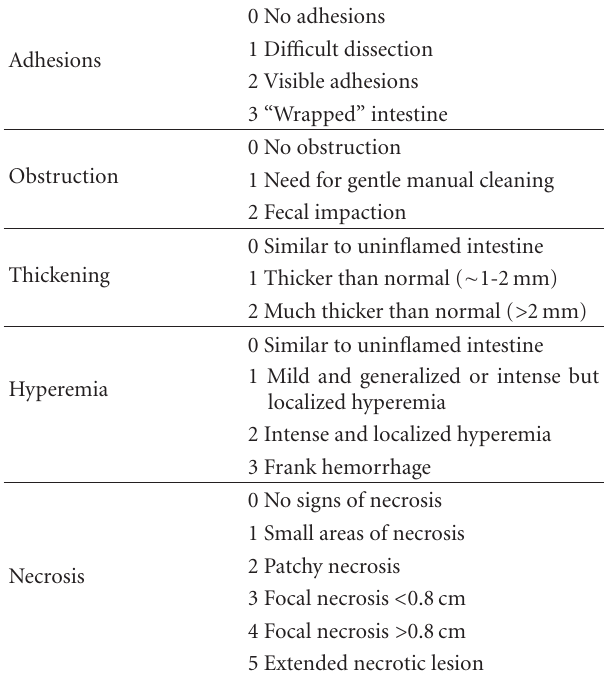
Table 1: Scoring criteria for assessment of macroscopic rat colonic